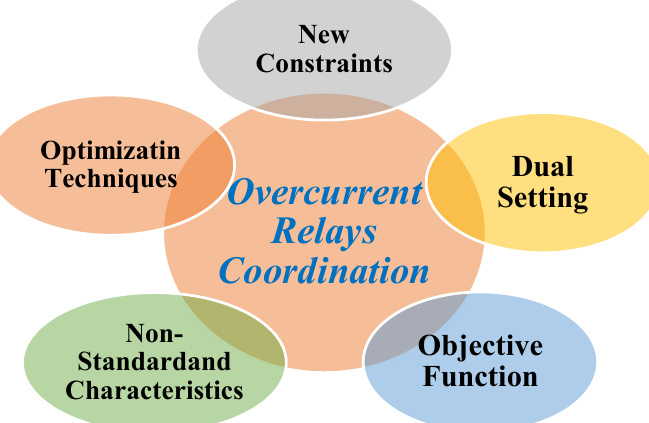
Figure 1. Overcurrent Relay Coordination Methods.